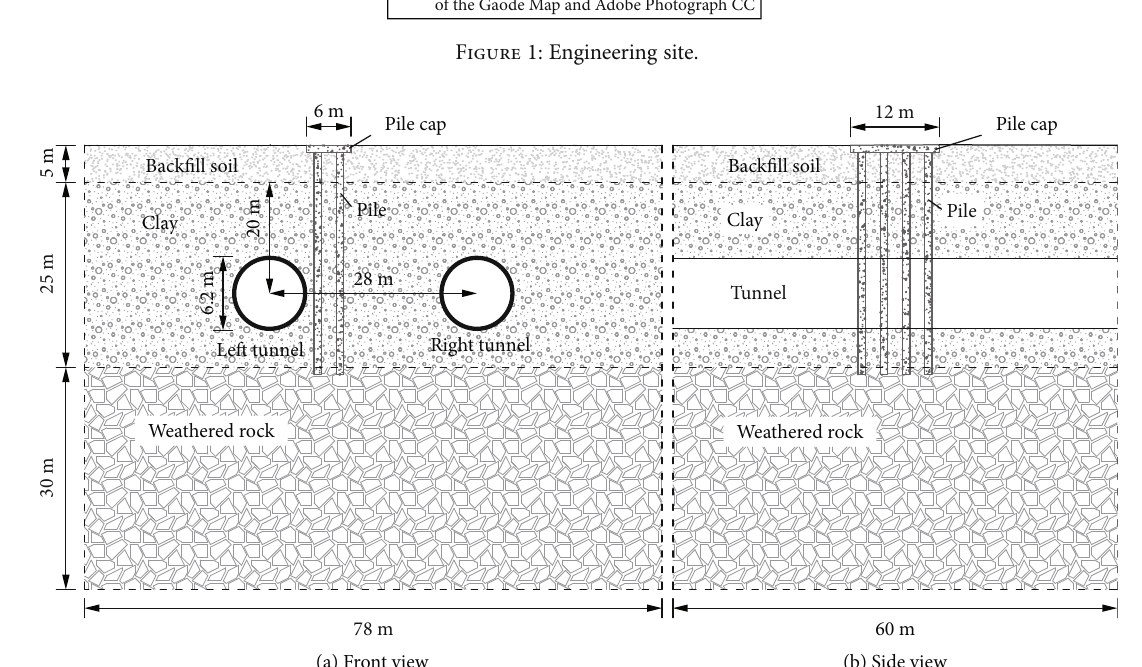
Figure 2: Front and side views of the considered engineering